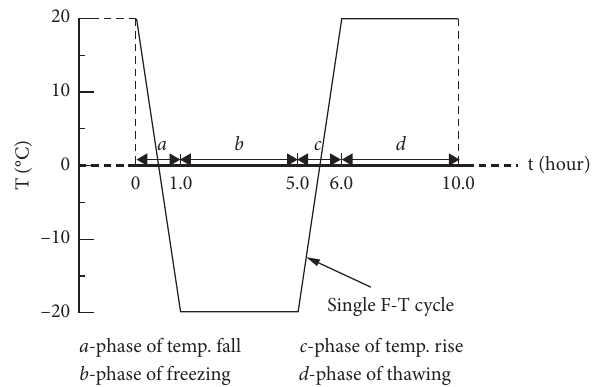
Figure 10: Temperature schematic diagram of F-T tests in a single cycle.